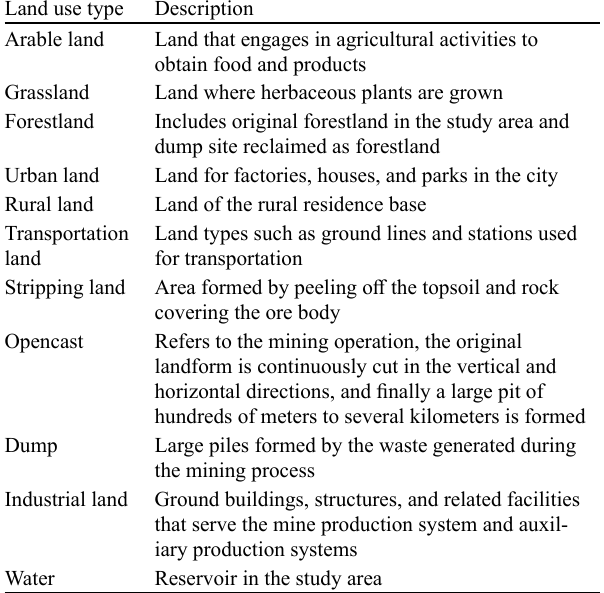
Table 2 Land use classification of open-pit coal mine based on remote sensing